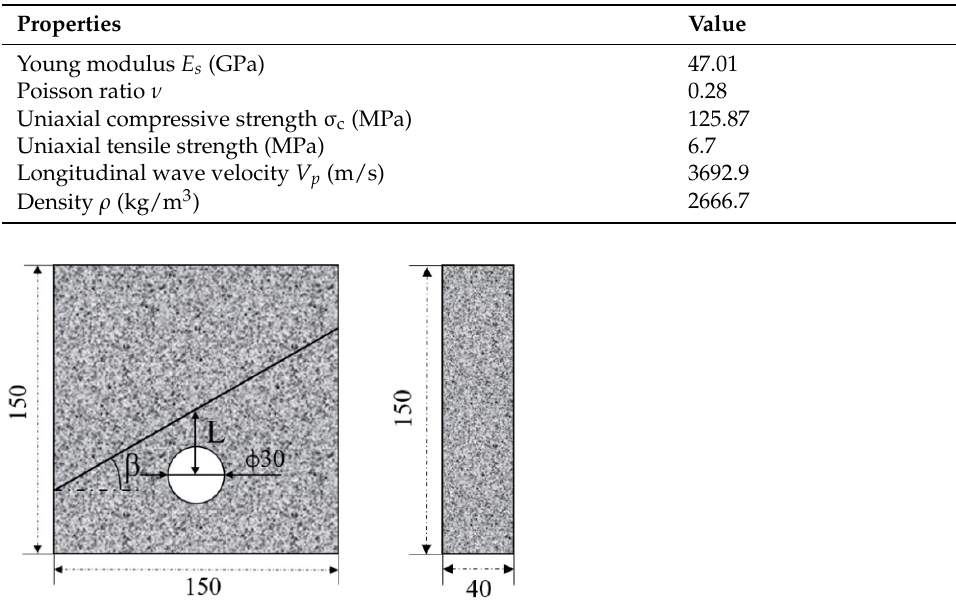
Figure 2. Schematic diagram of the granite sample in the biaxial compression test.